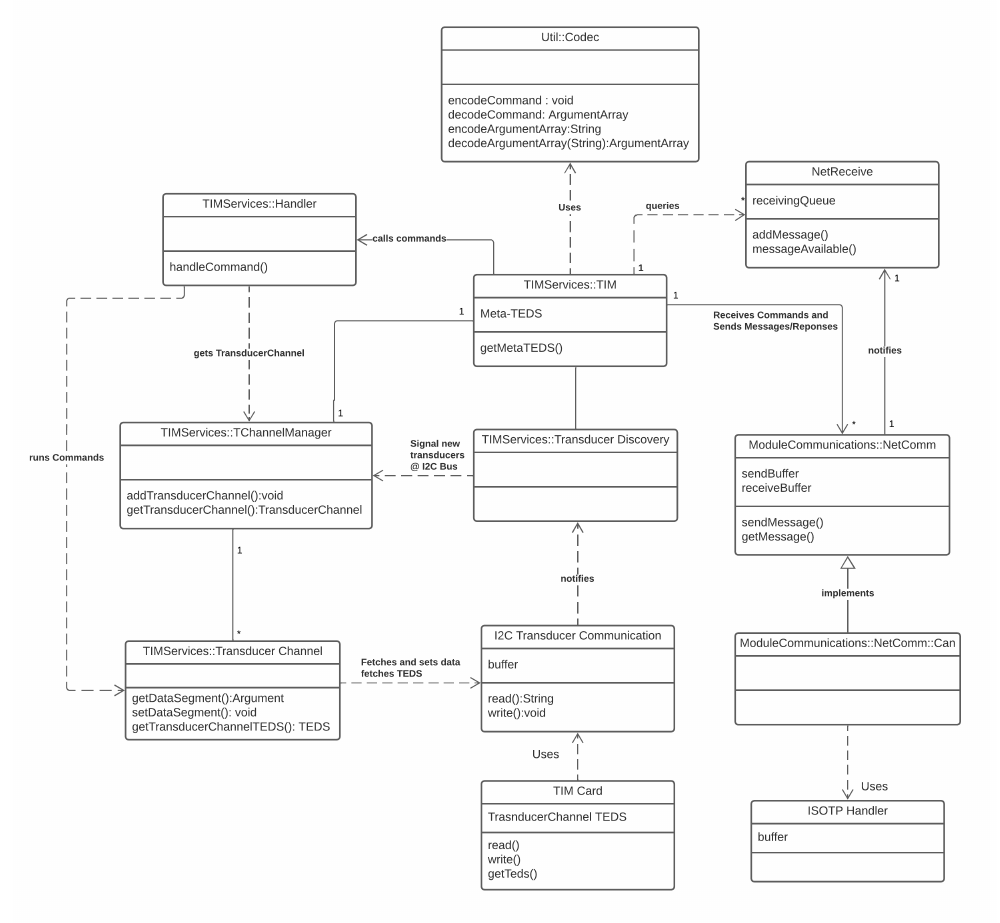
Figure 9. TIM architecture implementation UML class